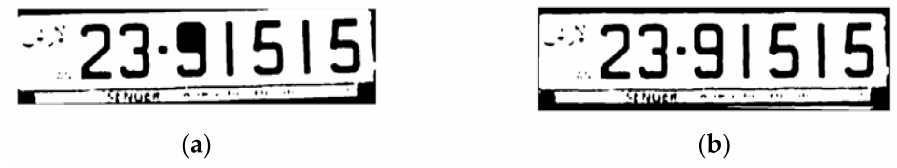
Figure 7. An example of image rotation. ( a ) A tilted image. ( b ) Image after